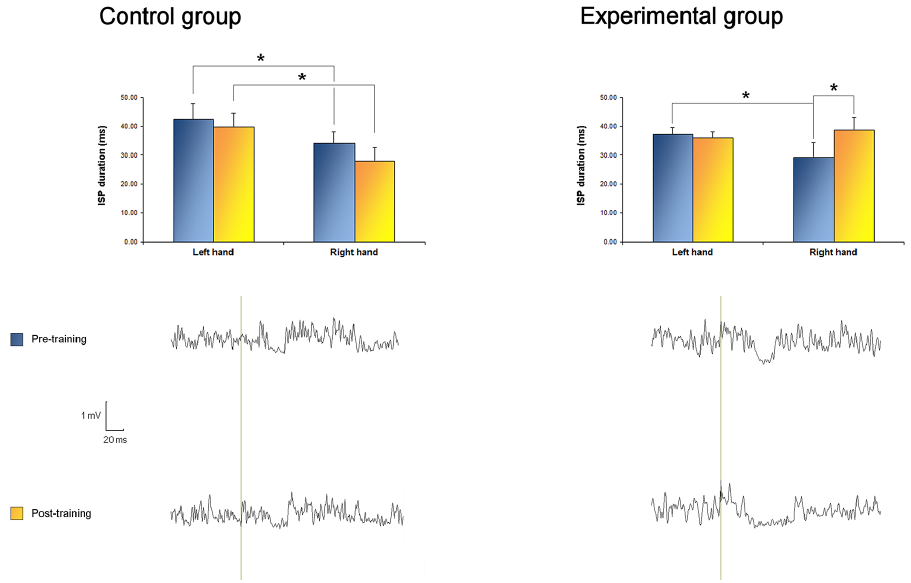
Fig 4. ISP APB duration. Top: bilateral ISP APB duration before and after training. In the control group, there was no significant effect of time. In both measurements, left ISP was larger than right. In the experimental group, right ISP APB duration was significantly greater after training, leading to symmetric ISP APB durations. Bottom: EMG traces recorded from the right APB muscle during right hemisphere TMS in one subject of each group, before (top) and after (bottom)